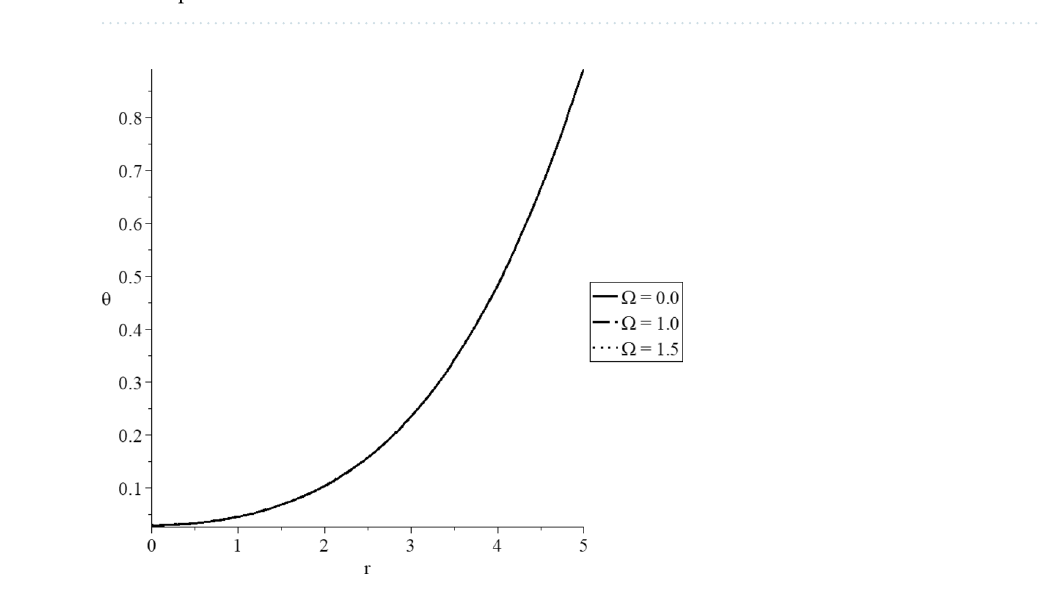
Figures 15 and 16 show that the angular velocity parameter has minimal effects on the dynamical and con- ductive temperature increment. Figure 17 represents that the angular velocity parameter has significant effects on the volumetric strain dis- tributions. The three curves start from the position r = 5.0 with zero values, and each curve has a peak point. The absolute value of the deformation increases when the value of the angular velocity parameter increases. The absolute value of the peak points of the volumetric deformation take the following order